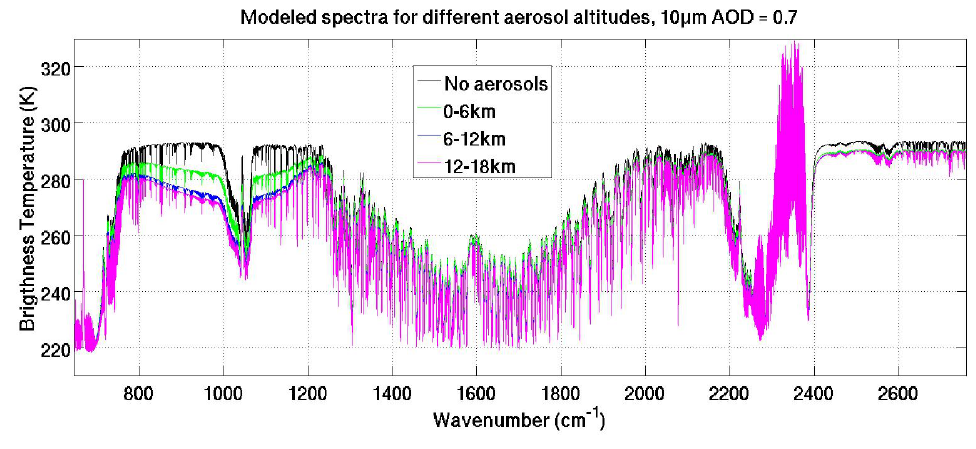
Figure 2. Simulated IASI-like spectra between 645 and 2760 cm − 1 with an aerosol layer at different heights. Ash concentration was consistently 50 particles/cm 3 , leading to a 10 µ m AOD of 0.7. The black spectrum is the reference without